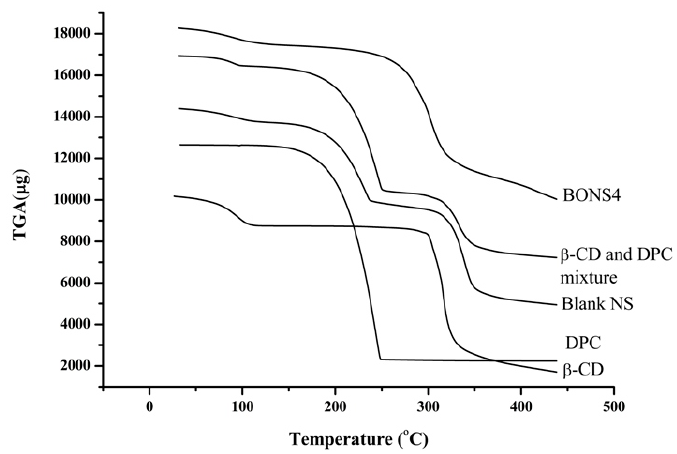
Figure 4. TGA curves of β -CD, DPC, blank NS, β -CD and DPC mixture, and BONS4.